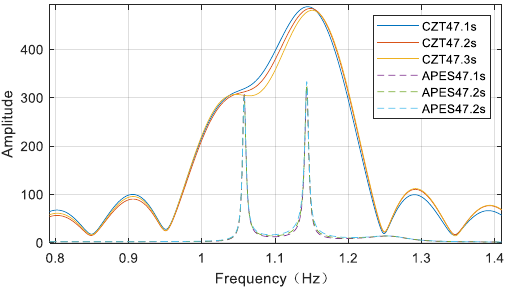
Figure 12. Spectrum slices of the CZT method at a different time (blue solid line at 47.1 s, red solid line at 47.2 s, and orange solid line at 47.3 s). Spectrum slices of the APES method at different times are constant.